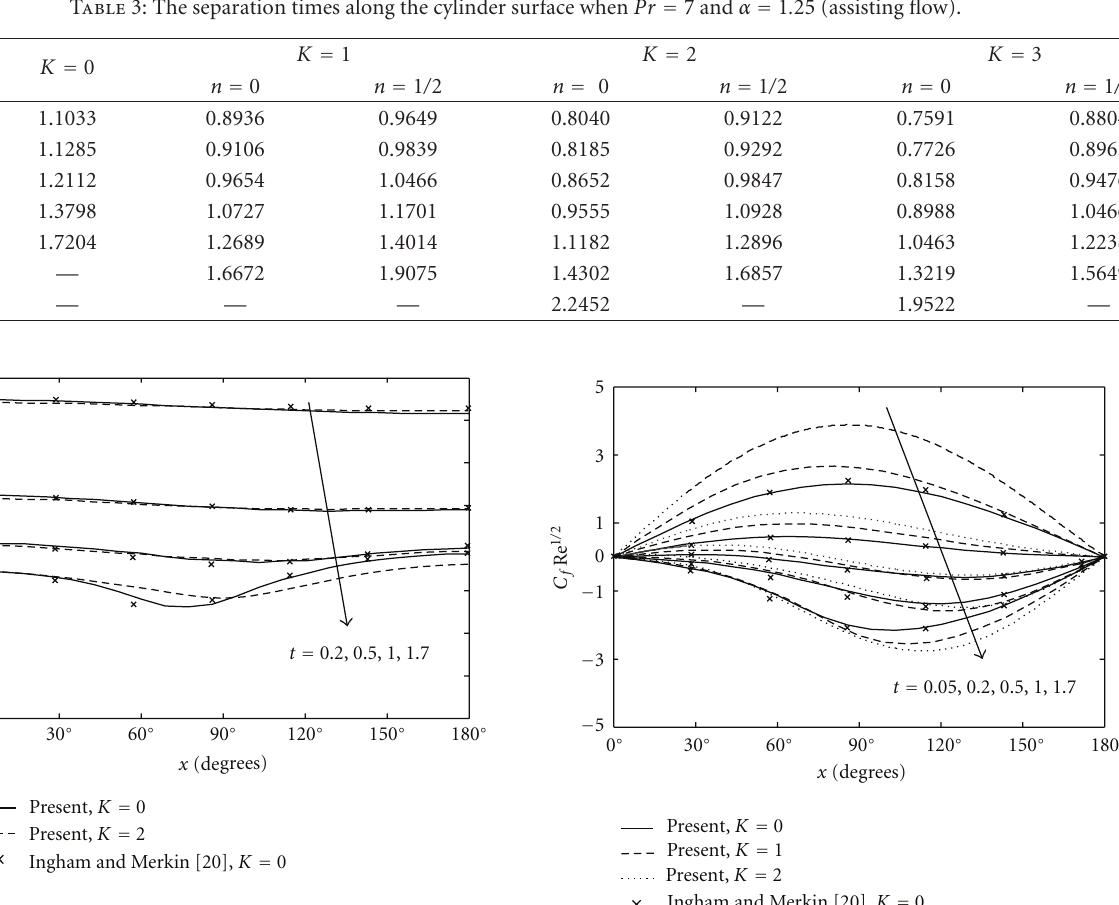
Figure 3: Variation of the Nusselt number with x for K = 0, 2 and for various values of t when Pr = 1, α = − 3 (opposing flow) and n = 0.